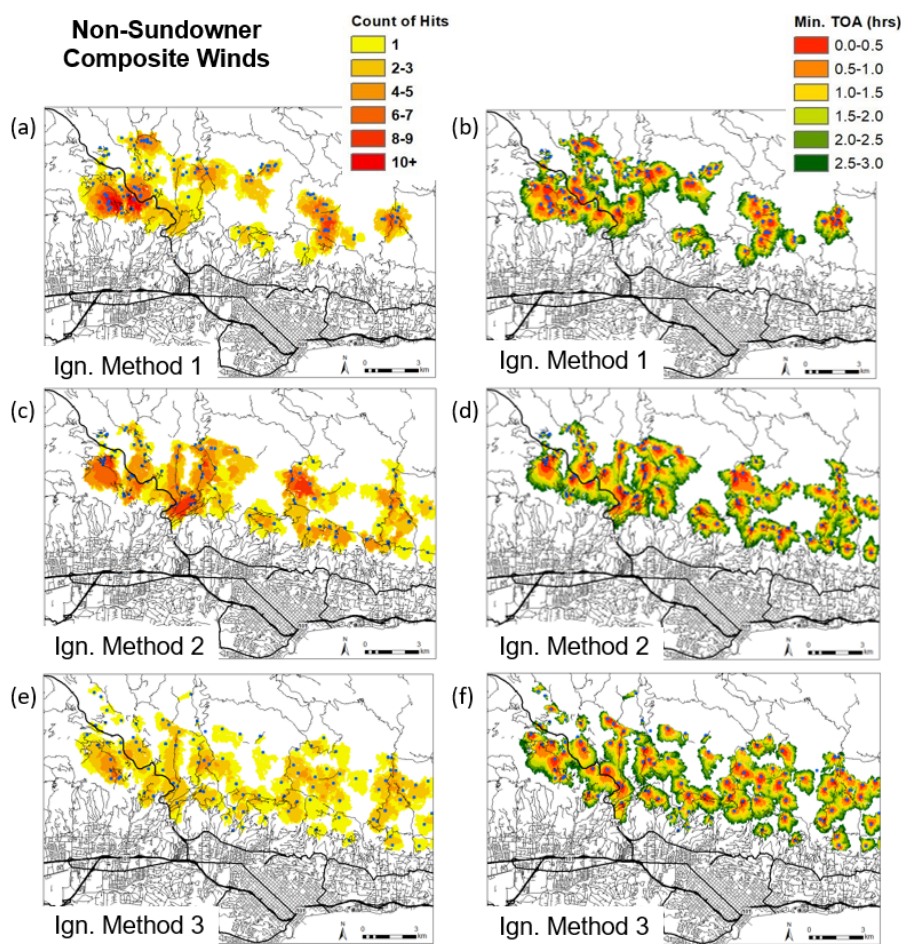
Figure 5. Maps showing the total number of hits by the 100 simulations at each grid cell ( a , c , e ) and the earliest time of arrival (TOA) at each grid cell in any of the simulations ( b , d , f ). Simulations were run using the non-Sundowner composite. Maps ( a , b ) show results from ignition method 1, ( c , d ) show results from ignition method 2, and ( e , f ) show results from ignition method 3. The lines are roads and trails, and the blue dots indicate the ignition locations for the specified ignition modeling method.